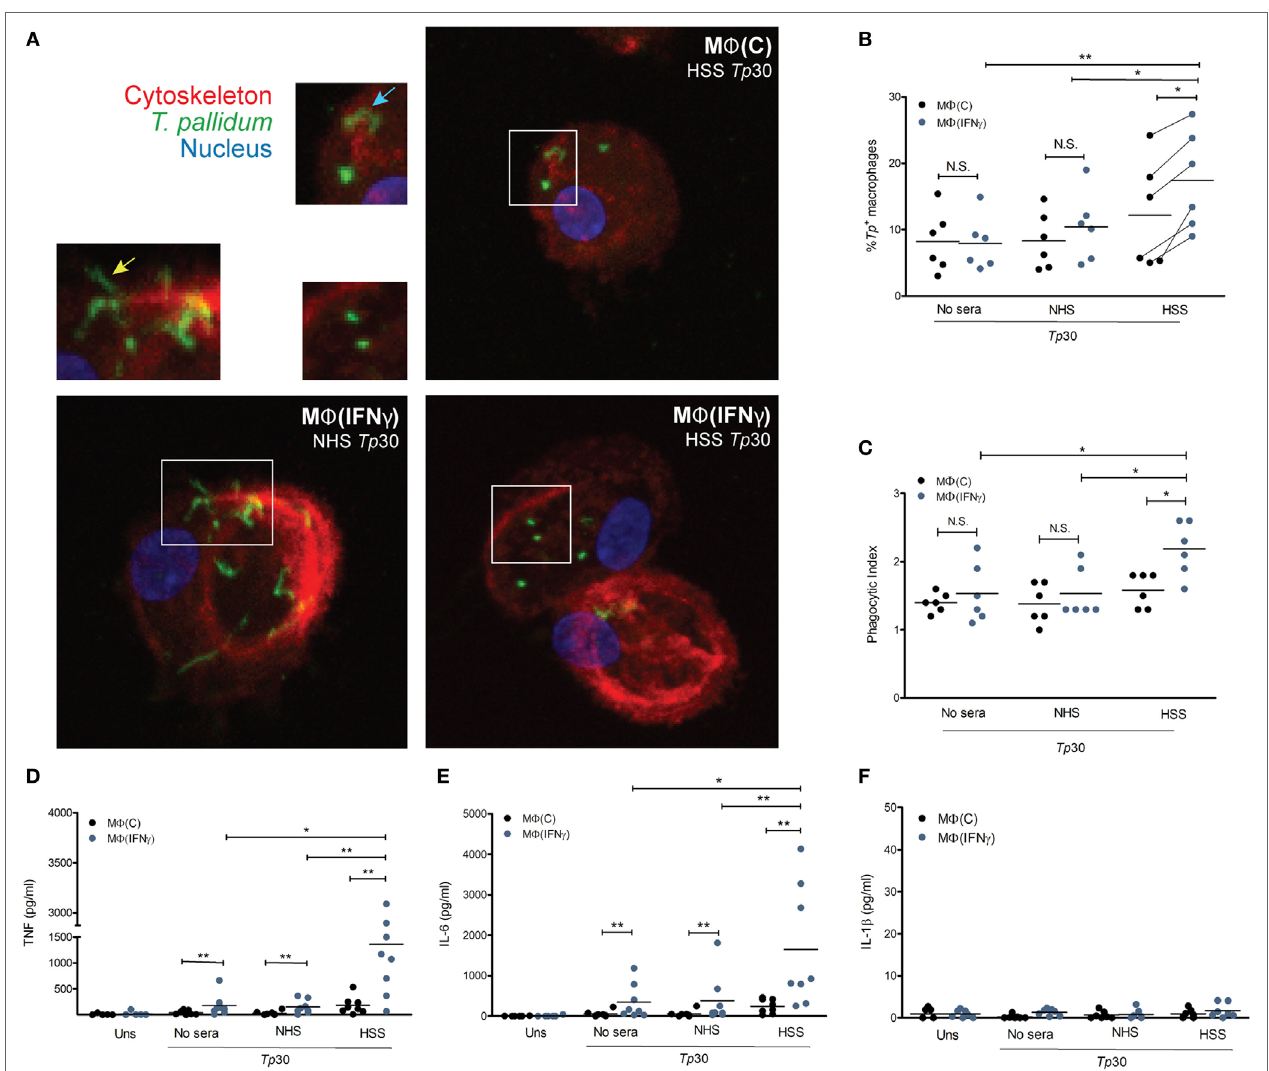
FigUre 4 | Treponema pallidum ( Tp ) uptake by IFN γ activated M Φ s. M Φ (C)s and M Φ (IFN γ )s were stimulated with MOI 30:1 of Tp for 8 h. Tp were either incubated alone (no sera) or where indicated with 10% heat inactivated normal human serum (NHS) or human syphilitic serum (HSS). (a) Following stimulation, macrophage cytoskeleton (red), Tp (green), and nucleus (blue) were labeled as described in Section “Materials and Methods.” Representative confocal micrograph of NHS- Tp (Lower left panel, and left inset) show spirochetes binding by tip attachment as well as laying entirely against the cell surface. Confocal micrographs are a composite display of 20 consecutive Z-stack planes. Internalization of Tp was observed with HSS as shown in the two right panels. Quantification of spirochetal uptake was calculated by (B) % Tp + macrophages and (c) phagocytic index. Phagocytosis of Tp was significantly enhanced by both HSS and IFN γ . Cytokine bead array was used to detect inflammatory cytokines in the culture supernatants following stimulation with Tp . (D) TNF and (e) IL-6 were significantly increased by M Φ (IFN γ )s following antibody-mediated uptake of Tp . (F) No IL-1 β was detected in any experimental condition. The statistical significance between the Tp conditions was determined by Friedman’s test with a Dunnett’s multiple comparison post-test analysis. N.S., not significant, * p -value of < 0.05, ** p -value of < 0.01, *** p -value of <